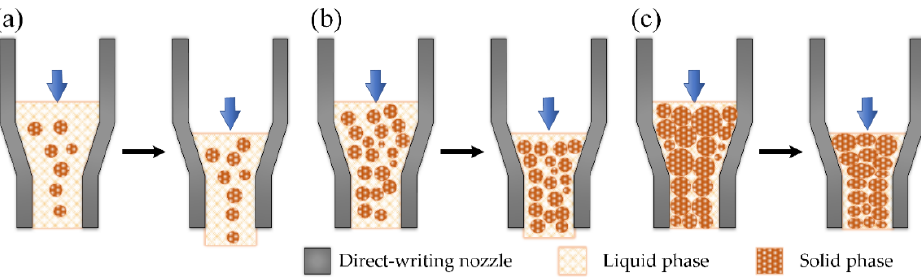
Figure 13. Schematic diagram of melting direct-writing principle, ( a ) high liquid volume fraction, ( b ) liquid-solid mixed flow, and ( c ) low liquid volume fraction.